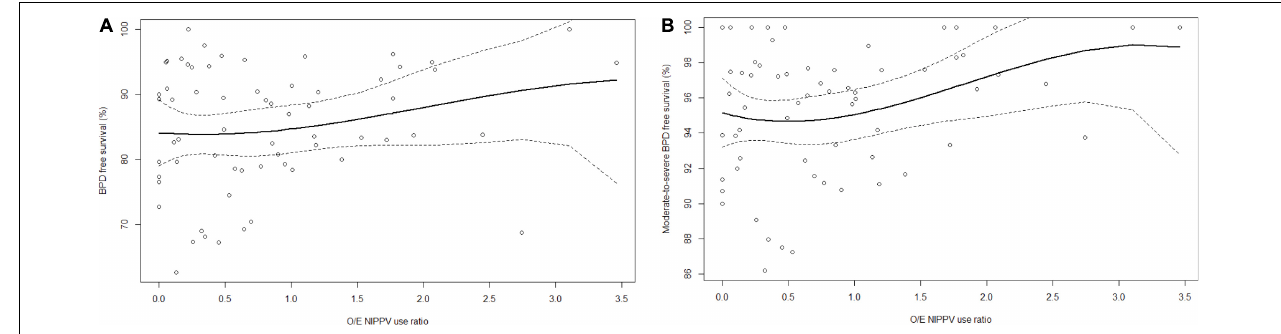
FIGURE 2 | Relationships between O/E ratio of NIPPV use and (A) BPD and (B) survival without moderate-to-severe BPD. Solid line represents fitted flexible regression curve using a cubic b-splines basis with three degrees of freedom. Dashed lines represent 95% confidence intervals.